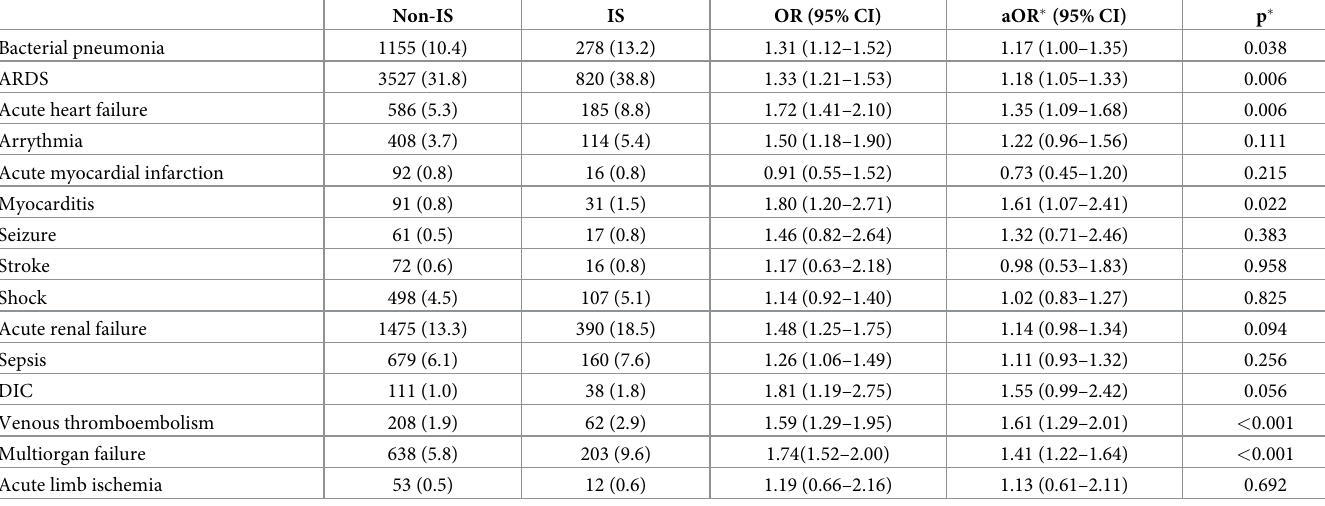
Table 4. In-hospital complications according to immune status: Number of patients developing in-hospital complications, and crude and adjusted OR compared to non-immunosuppressed patients. Non-IS IS OR (95% CI) aOR � (95% CI) p